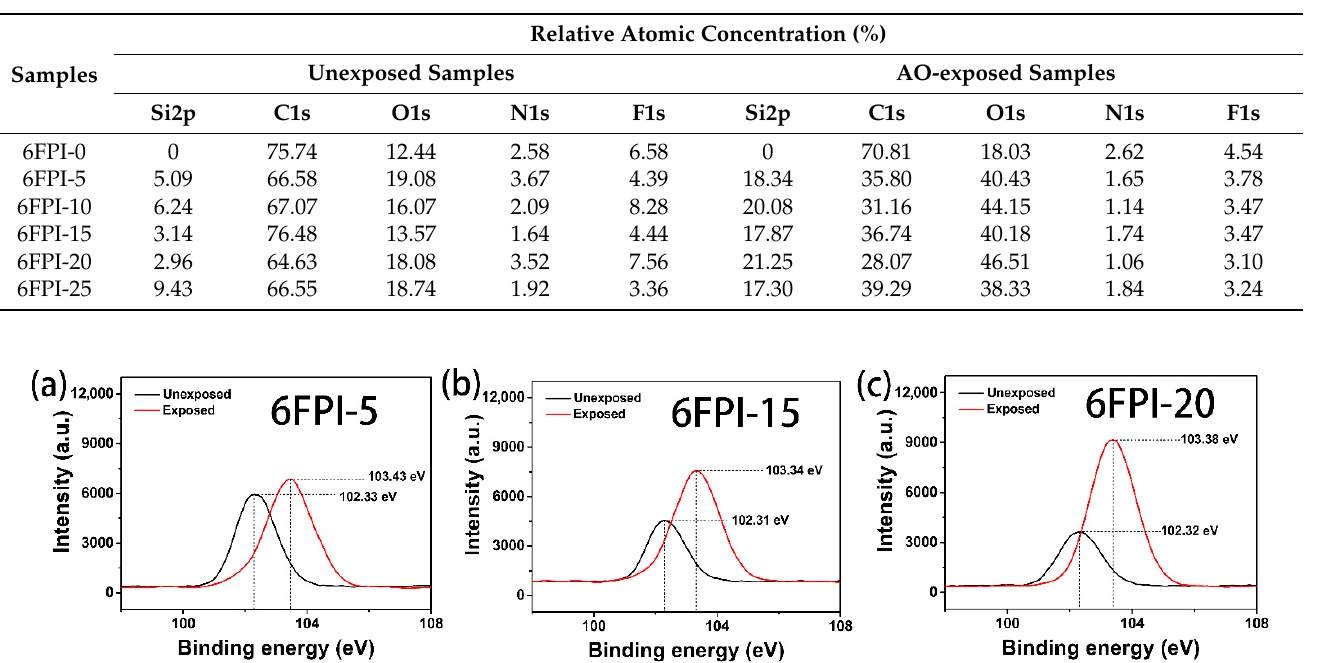
Table 5. XPS results for the AO-exposed and unexposed PI films.